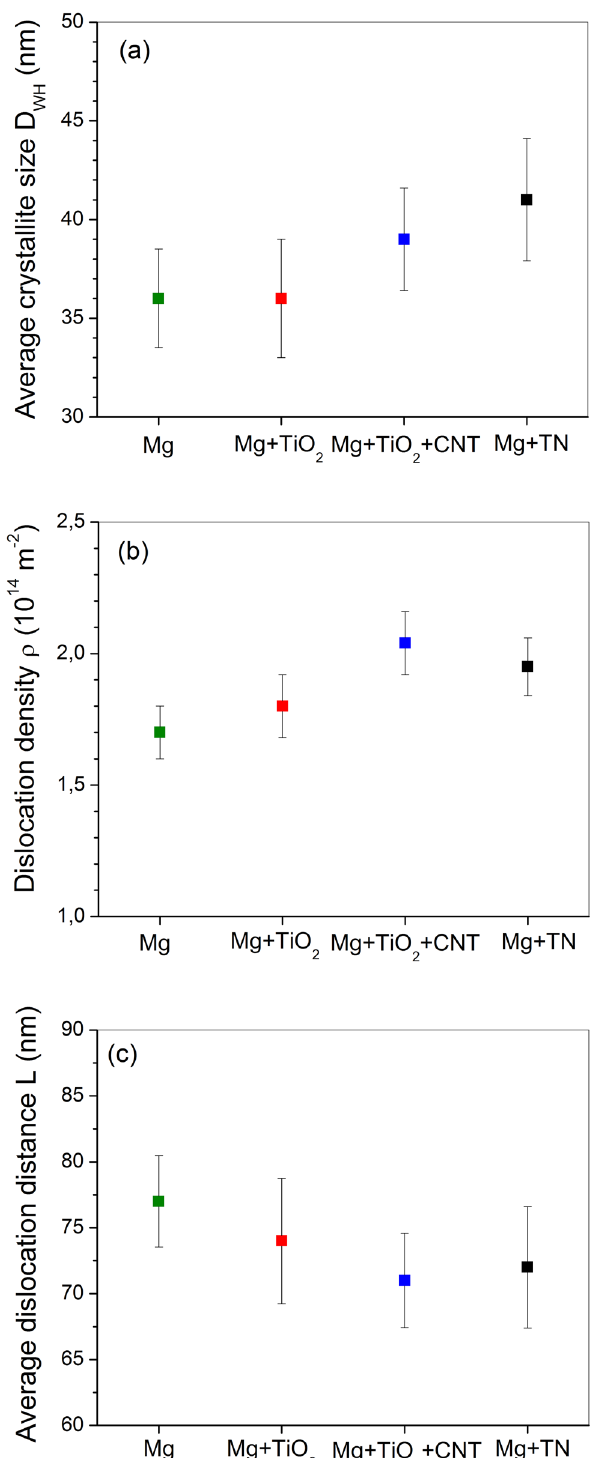
Figure 6: Microstructural parameters ( a ) average crystallite size, ( b ) dislocation density and ( c ) average dislocation distance obtained from the modi fi ed Williamson – Hall